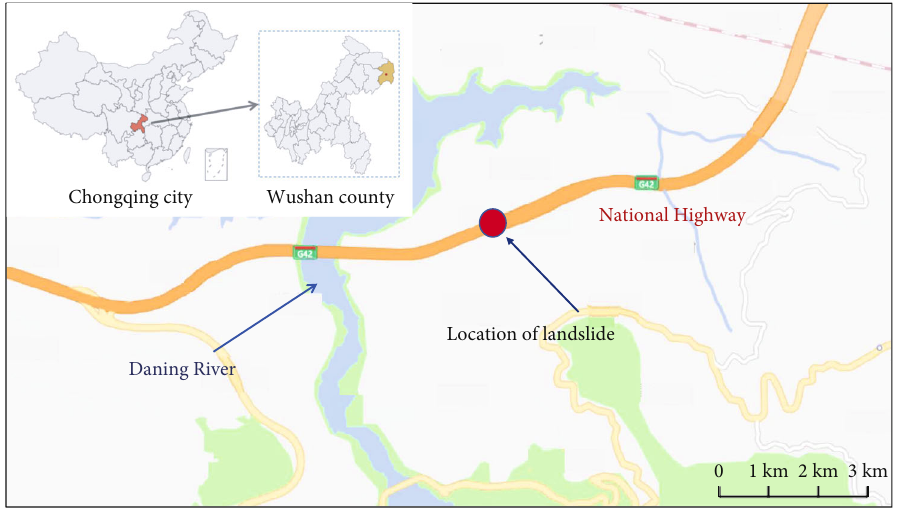
Figure 1: Landslide position information.